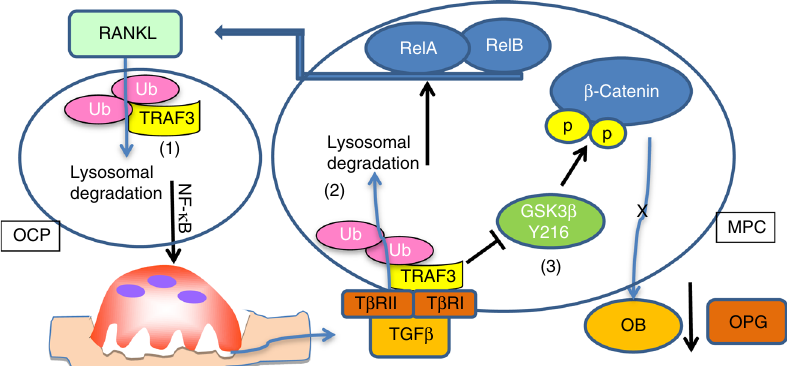
Fig. 7 Model of TRAF3 degradation during aging leading to bone loss. ( 1 ) During aging, increased RANKL expressed by MPCs induces TRAF3 ubiquitination and subsequent lysosomal degradation in osteoclast precursors (OCP) to stimulate osteoclast formation and bone resorption through NF- κ B 12,14 . As a result, increased amounts of TGF β are released from bone matrix and activated in the acid environment in resorption lacunae. ( 2 ) Activated TGF β induces TRAF3 ubiquitination and subsequent lysosomal degradation in MPCs. As a result, both RelA and RelB are activated to promote RANKL production, further enhancing bone resorption. In addition, ( 3 ) in MPCs, TRAF3 binds to the TGF β R and negatively regulates GSK-3 β activity to prevent β -catenin degradation, allowing β -catenin accumulation and nuclear translocation to maintain osteoblast differentiation and secretion of OPG 52 , which limits osteoclast